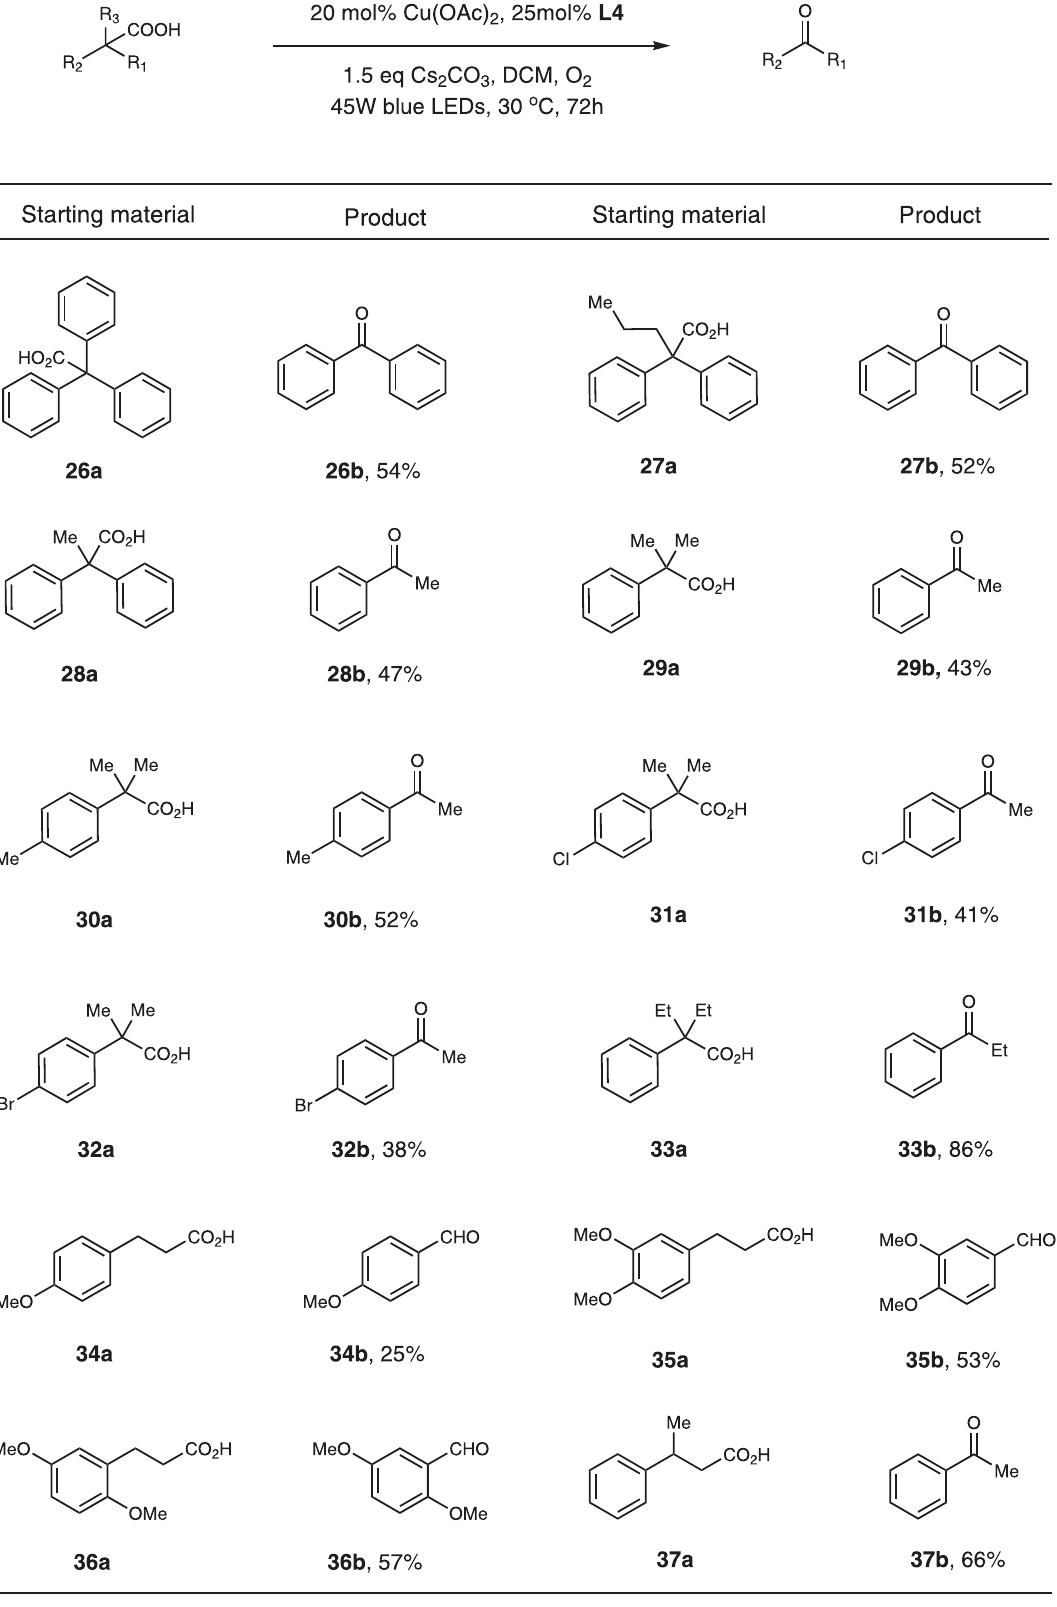
Fig.4|Substratescopeofacyclicacids. Reactionconditions:substrate(0.5mmol), Ir-2 (0.015mmol),Cu(OAc) 2 (0.1mmol), L4 (0.125mmol),Cs 2 CO 3 (0.75mmol),DCM (10mL), 45W blue LEDs, 30°C,